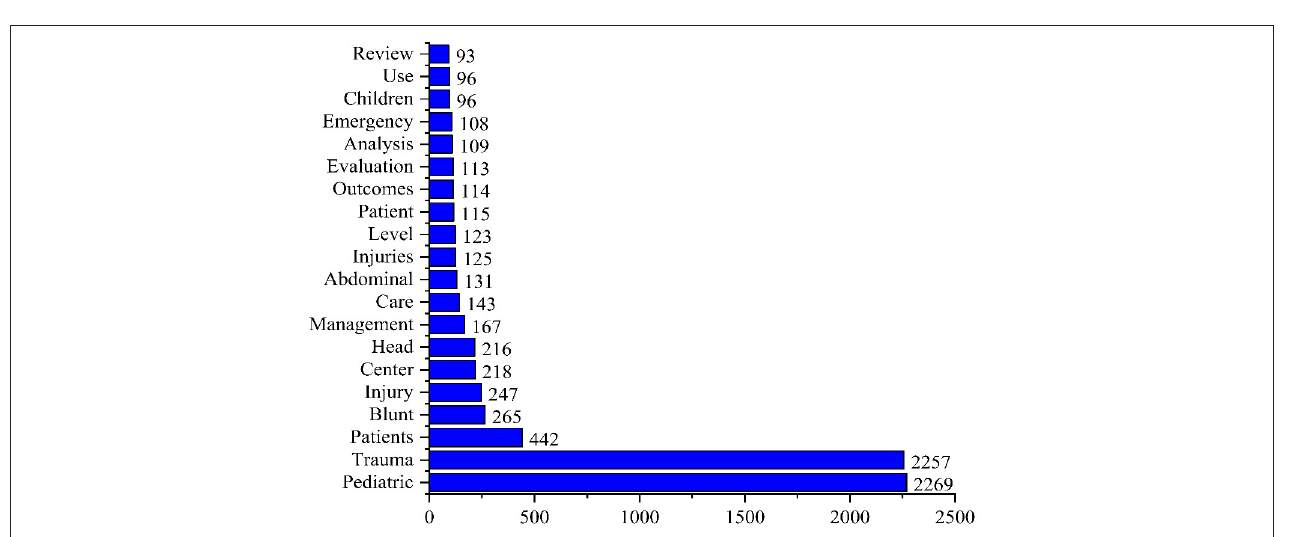
FIGURE 2 | Top 20 most commonly used